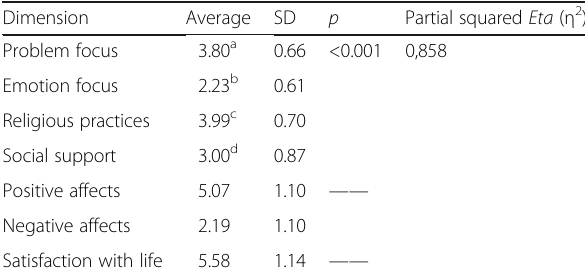
Table 2 Descriptive statistics of PCMS and SWB dimensions Dimension